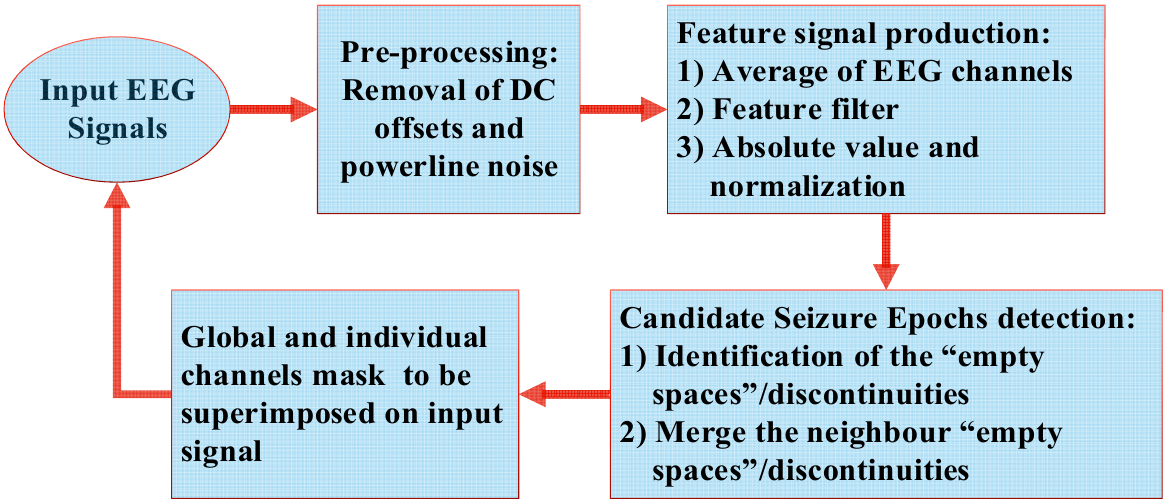
Figure 2. Logical flowchart of the proposed seizure-detection algorithm. The loop is repeated once for every dataset of one hour in length. An expert can review the results of both manual and automated data to identify any variations in false alarms and make corrections within a few minutes.